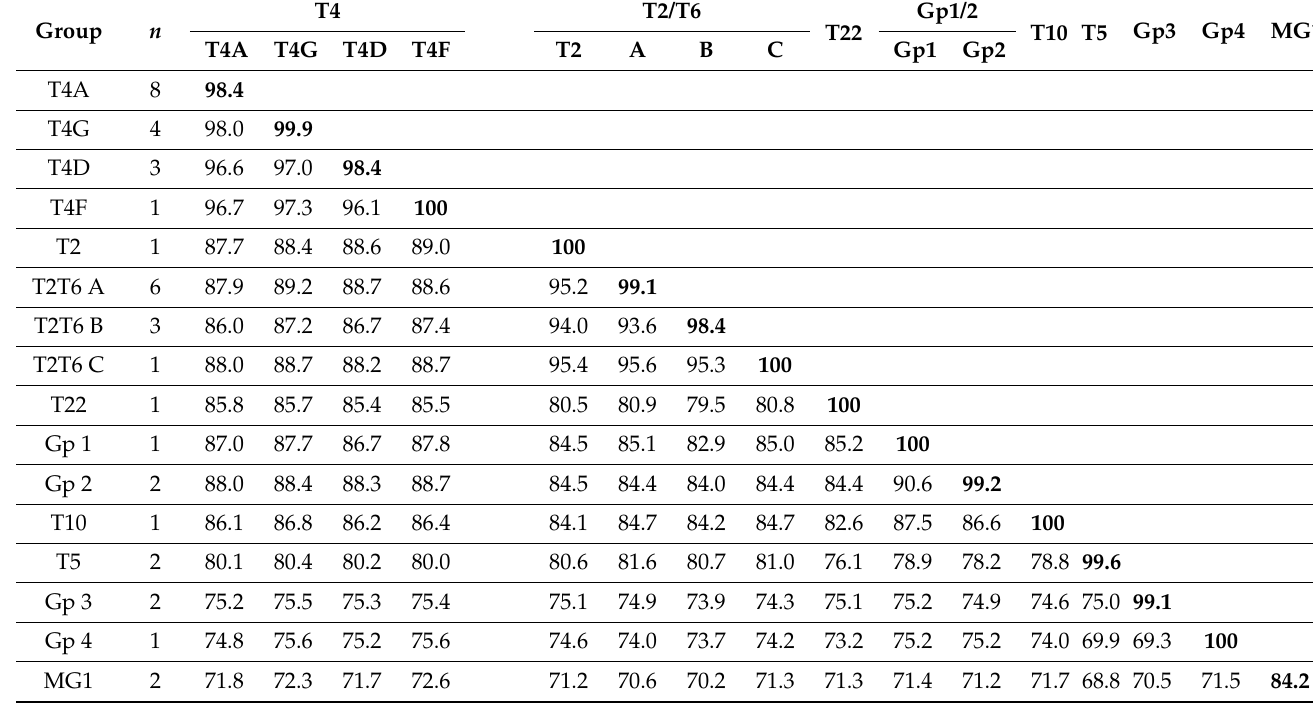
Table 5. Mean pairwise similarity values (%) for the partial Acanthamoeba LSU rDNA sequences.